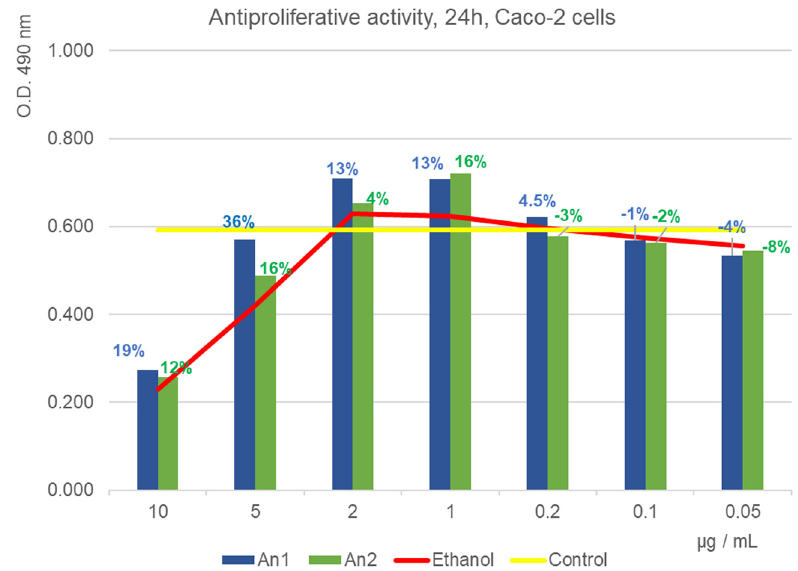
Figure 6: Caco - 2 cell antiproliferative test response after the treatment with the three - test samples ( An1, An2, and 40% ethanol dilution series ) in comparison with the control negative series, at 24